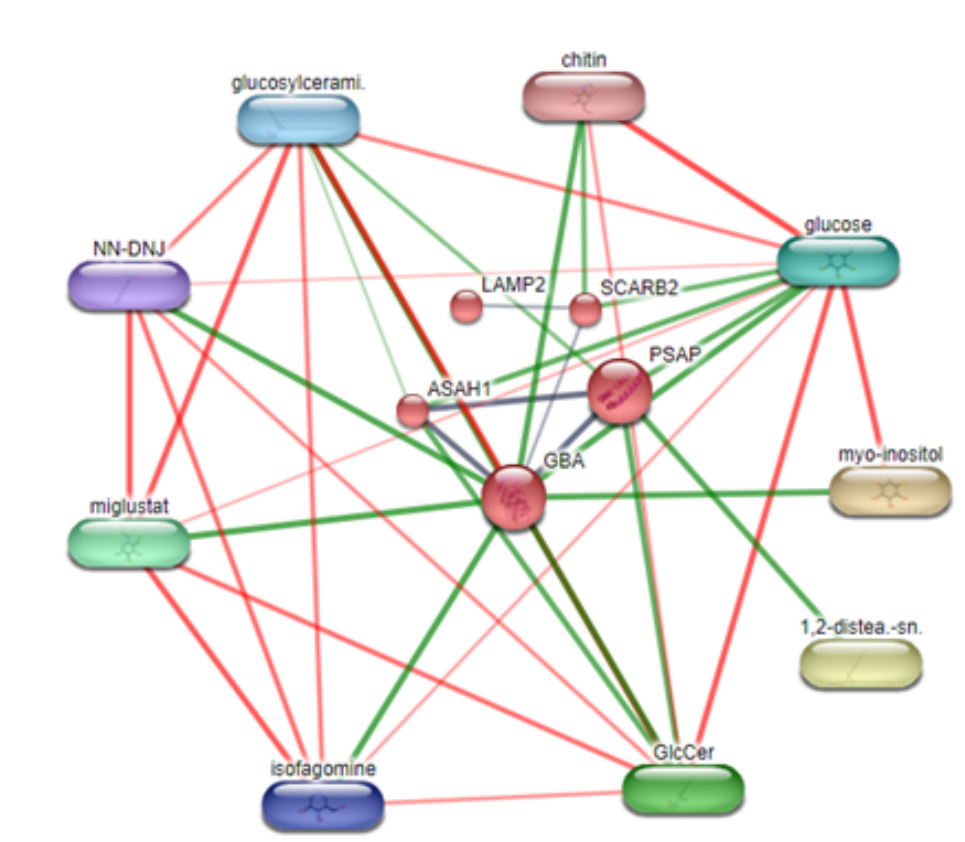
Figure 1. Interaction network between the GBA gene and associated genes [Elaboration: Own source, STICH